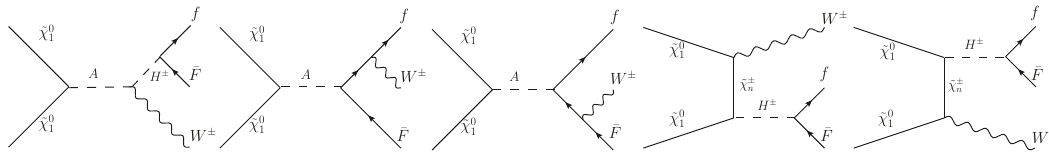
Figure 2 . Gauge invariant set of amplitudes for neutralino DM annihilation into a fermion pair and a W boson, mediated by s -channel bosons with a mass at the scale of the CP -odd Higgs A .